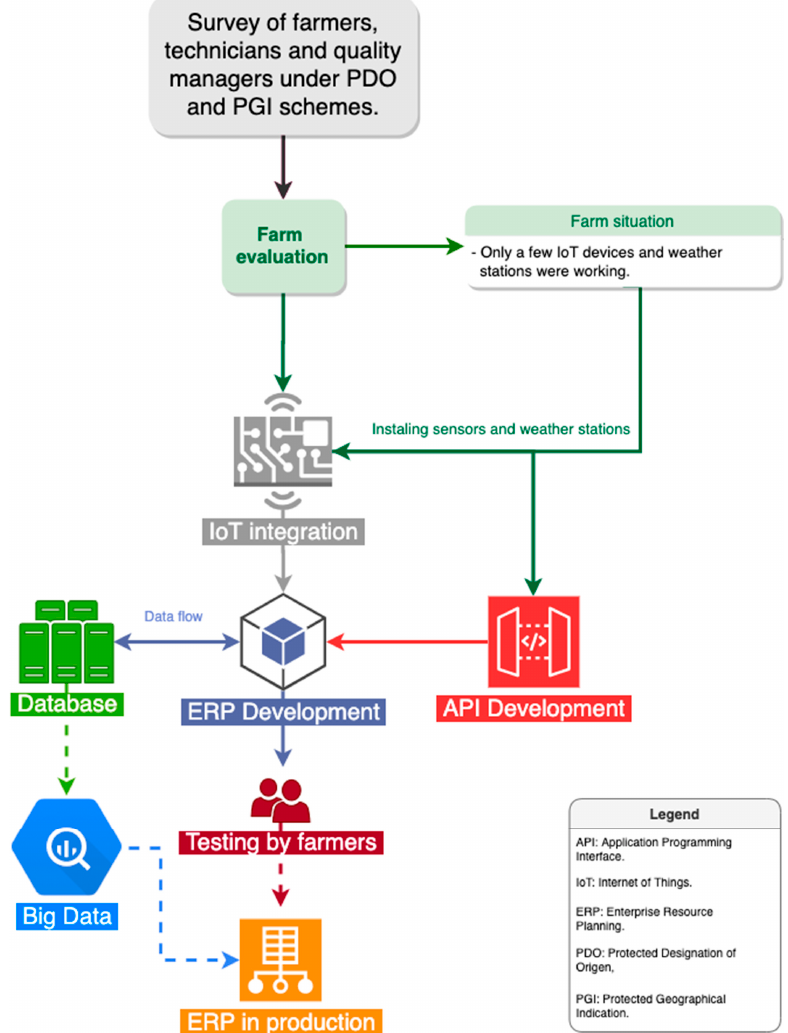
Figure 2. Flowchart of the different steps of the research methodology.